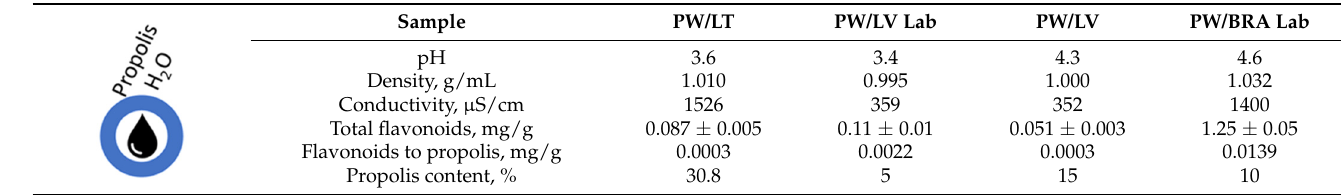
Table 1. Propolis water samples properties.